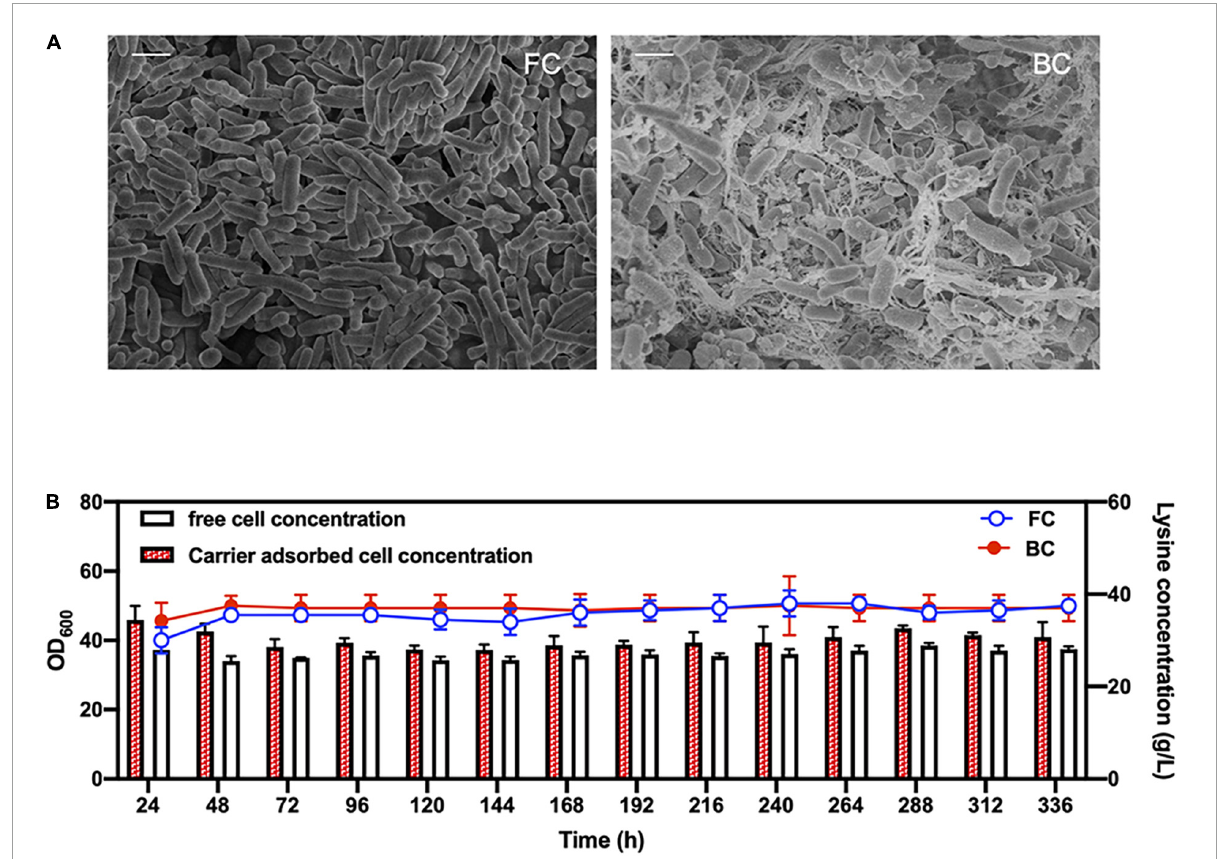
FIGURE1 Performance of C. glutamicum biofilm cells in fermentation. (A) SEM images of free cells (FC) and carrier-attached biofilm cells (BC) during fermentation. Scale bar, 1 µ m. (B) Lysine production of Cg-0206 cells and cell concentrations of Cg-0206 biofilm cells during repeated-batch